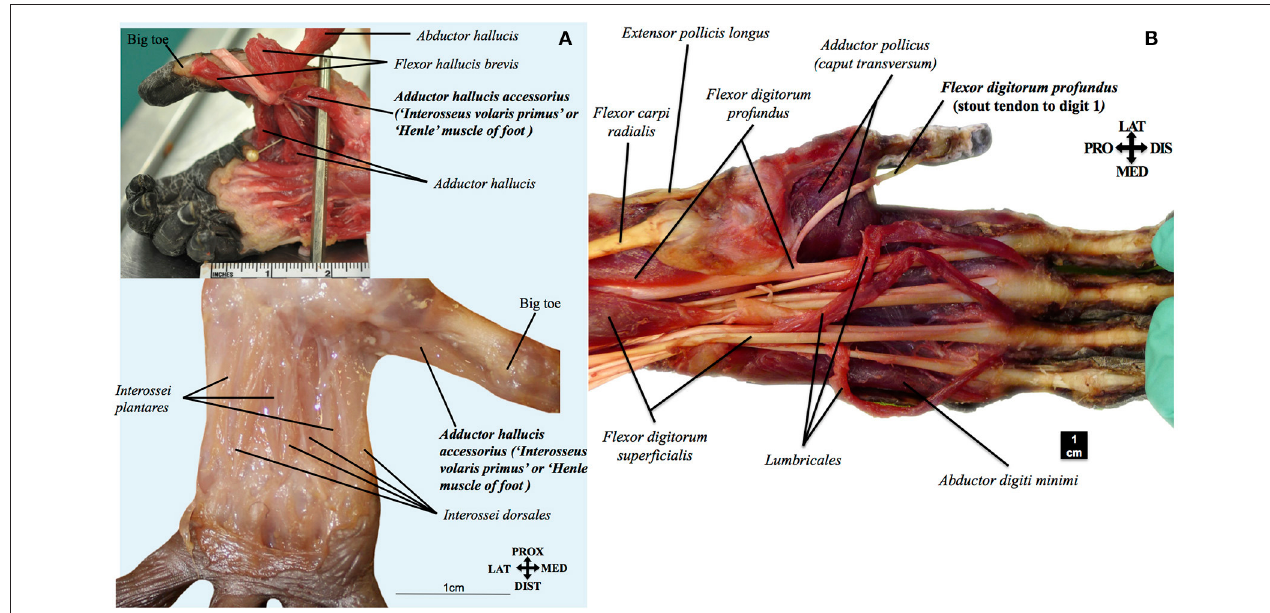
FIGURE 5 | (A) Pan paniscus : top ZIMS 164047, Jasiri, adolescent female; bottom ZIMS 164052, Ano, fetus female. Plantar view of the deep muscles of the foot, showing the presence of adductor hallucis accessorius (interosseous volaris primus of Henle). Modified from Diogo et al.’s photographic atlas of bonobos Diogo et al. (2017a); © Diogo has copyright of this atlas. (B) Pan paniscus (ZIMS 164031, Kidogo, adult male): palmar view of the superficial muscles of the left hand, showing that the tendon of the flexor digitorum profundus to digit 1 is a stout, non-vestigial structure in bonobos, contrary to common the configuration often seen in common chimpanzees, gorillas, and orangutans. Modified from Diogo et al.’s photographic atlas of bonobos Diogo et al. (2017a); © Diogo has copyright of this